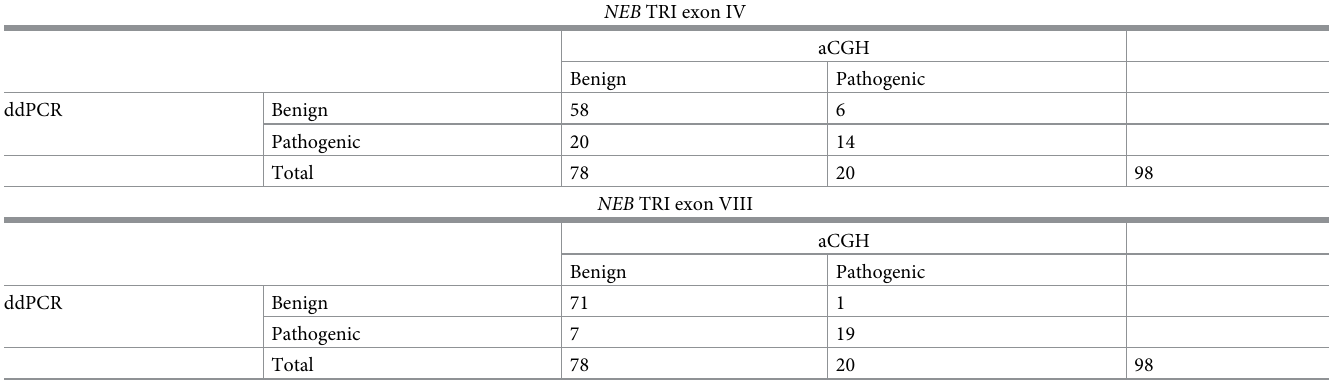
Table 2. The Kappa tables for detection of pathogenicity of assays NEB TRI exon IV and exon